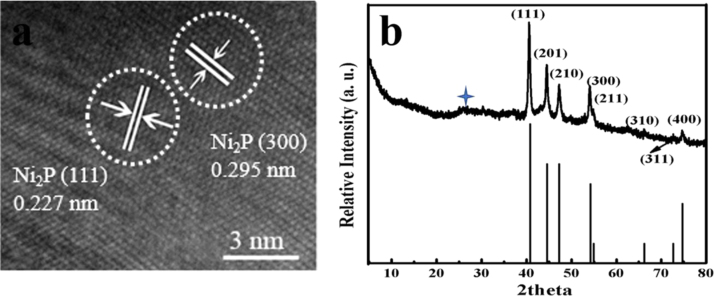
(a) HRTEM and (b) XRD of Ni2P/NG/Ni2P.